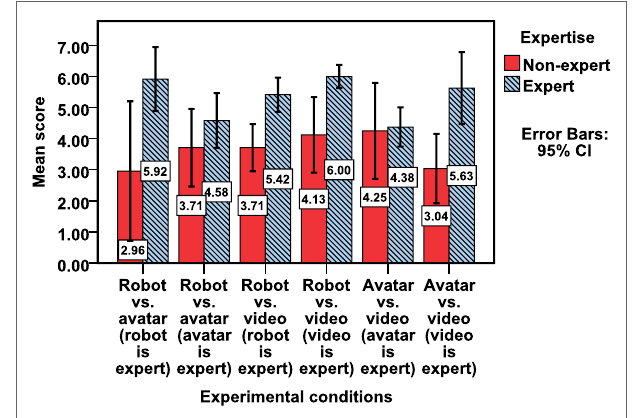
FigUre 6 | advice-seeking behavior for the final high-stakes question